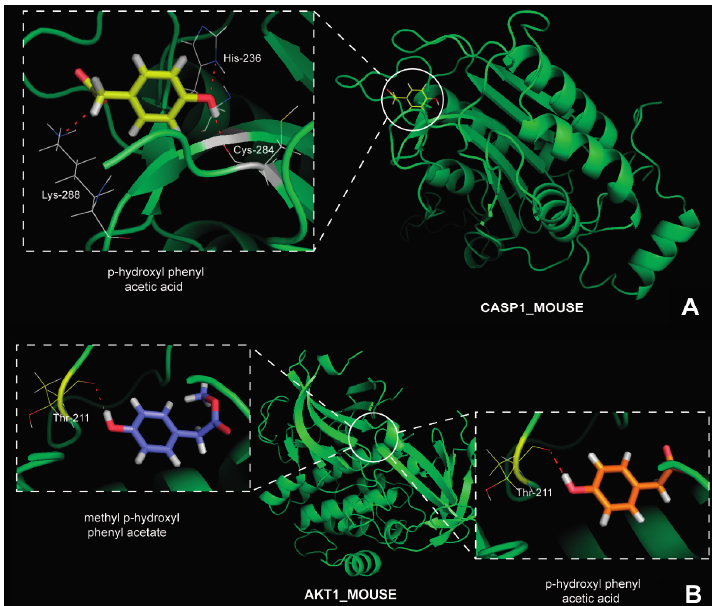
Figure 3. ( A ) The binding mode of compound 13 in caspase-1; and ( B ) the binding mode of compounds 10 and 13 in Akt-1.